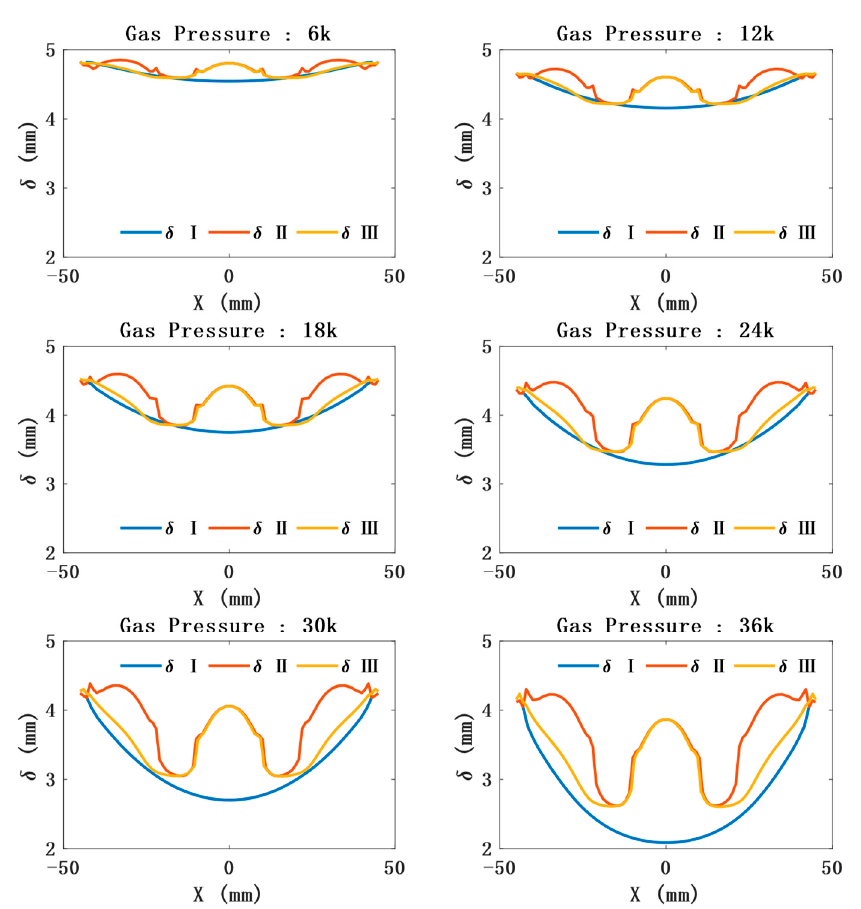
Figure 8. Relationship between the distance from the central axis (the distance relative to the ambient air pressure of 0 Pa) and the thickness change under different air pressures. δ I represents the thickness variation law of a circular thin plate; δ II represents the thickness variation law of the soft pneumatic compound eye model with the maximum constraint; that is, it is constrained by three sensors and passing through the central axis; δ III represents the thickness variation law of the soft pneumatic compound eye model with the least constraint; that is, it is constrained by only one sensor, located in the center and passing through the central axis.